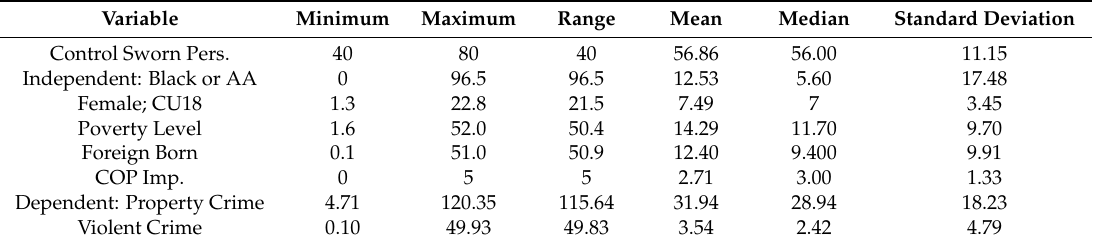
Table 1. Measures of Central Tendency of Independent, Dependent, and Control Variables ( n = 309). Variable Minimum Maximum Range Mean Median Standard Deviation Control Sworn